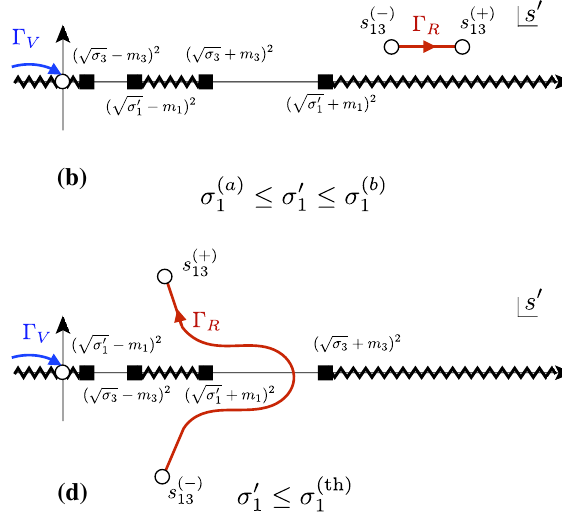
Fig. 10 Cut structure of the OPE integrand Eq. (46) in the s (cid:6) -plane, and the OPE integration paths for the RPE contour ( (cid:16) R in red) and the VPE contour ( (cid:16) V in blue) for the dispersive integral Eq. (48). The four cases as a function of σ (cid:6)